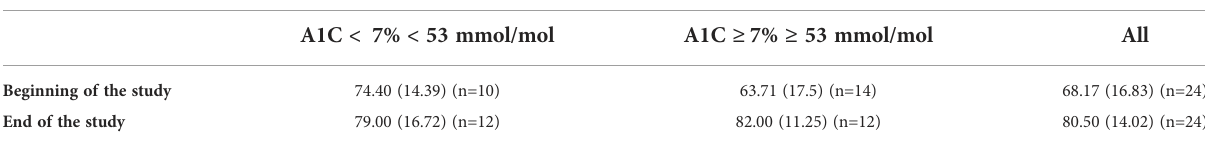
TABLE 5 Post – hoc comparison of average World Health Organization – Five Well – Being score (WHO-5) among children and adolescents with A1C < 7% (< 53 mmol/mol) versus children and adolescents with A1C ≥ 7% ( ≥ 53 mmol/mol). Organization-Five Well-Being Index (WHO-5) Mean (SD)